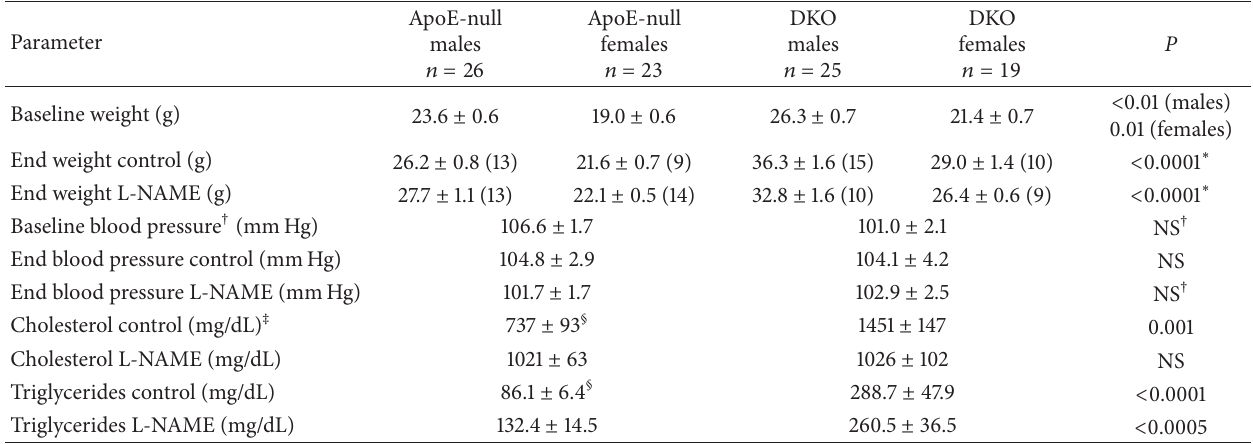
Table 1: Animals weights and systolic blood pressure at baseline and following treatment and biochemical measurements at the end of the study. The number of mice in each subgroup is shown in